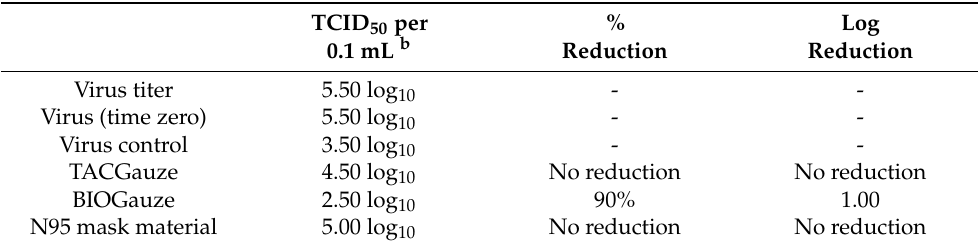
Table 4. Preliminary results of the virucidal activity of prototypes tested against human coronavirus a microorganism with a contact time of 6